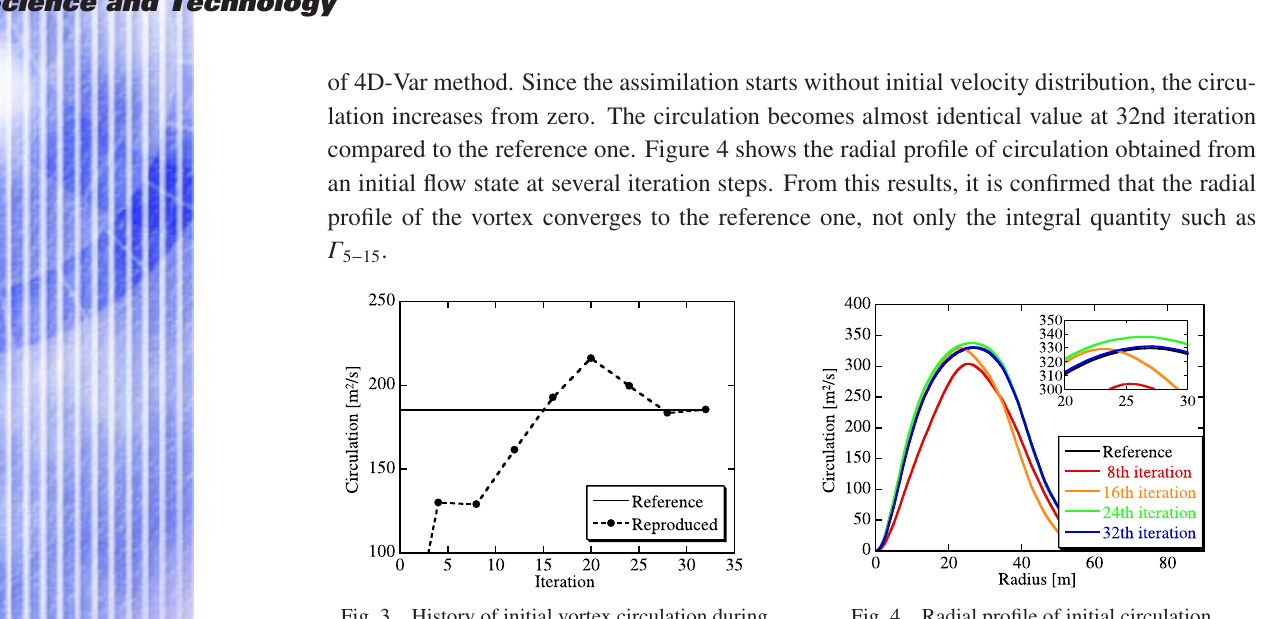
Fig. 3 History of initial vortex circulation during the iteration of 4D-Var method